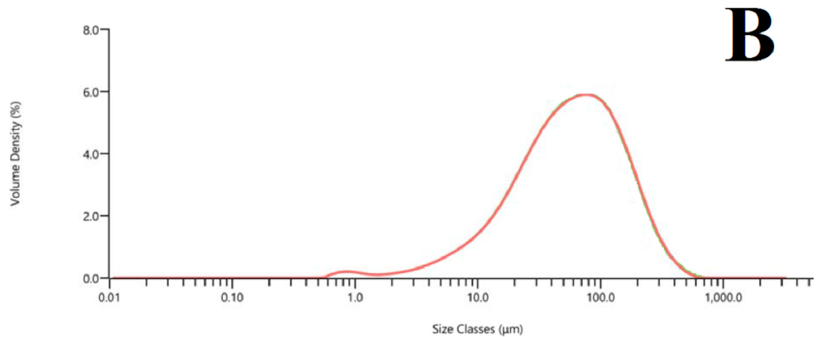
Figure 5. ( A ) scanning electron microscope (SEM) micrographs and ( B ) particle size distribution (volume density vs. size) of the used fly ash.